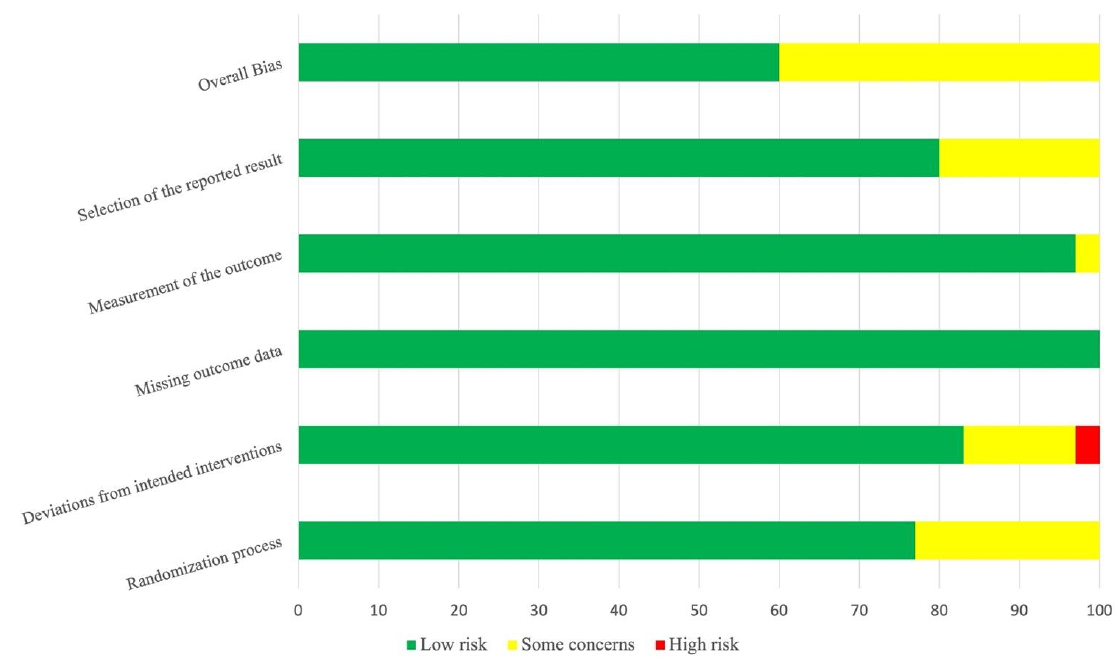
Figure 2. Risk summary of bias. For each risk of bias item, proportion of studies included in the meta-analysis ( k = 42) with low, high, or unclear risk according to authors’